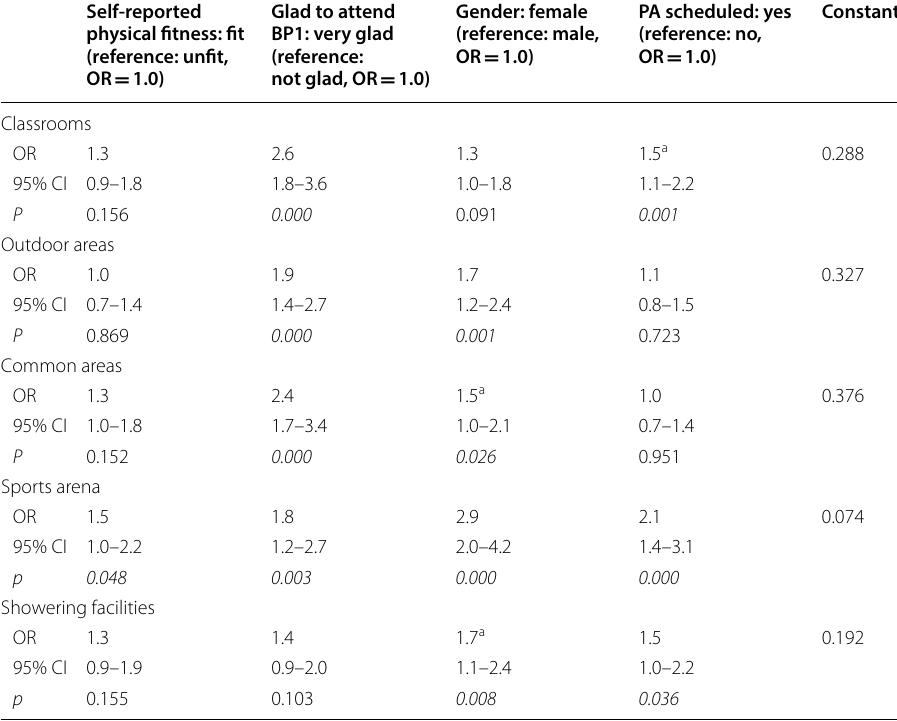
Italic values are statistically significant (p